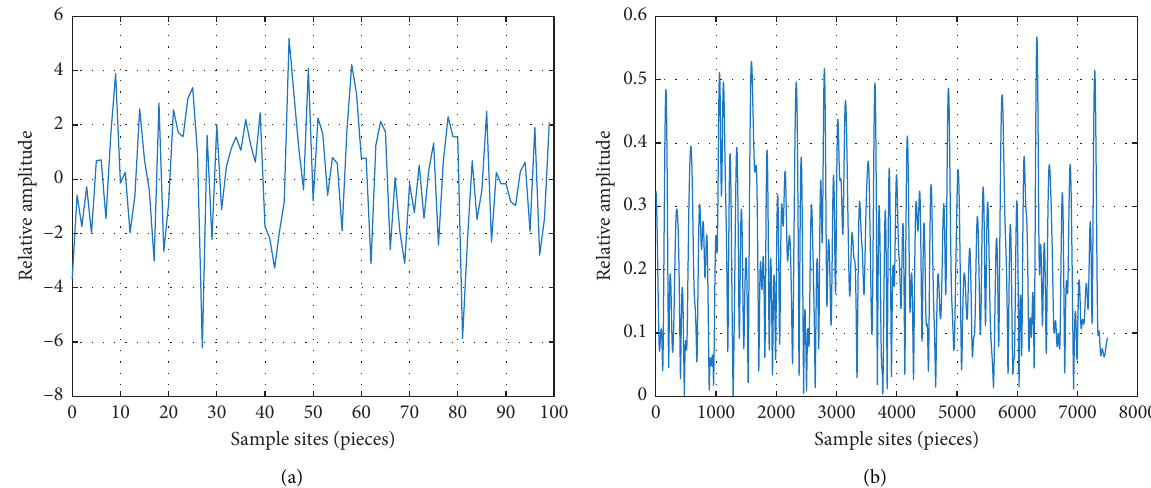
Figure 5: Speech waveform and local adjustment factors. (a) U � 2 compressed English listening audio retrieval performance. (b) U � 0.5 compressed English listening audio retrieval performance.